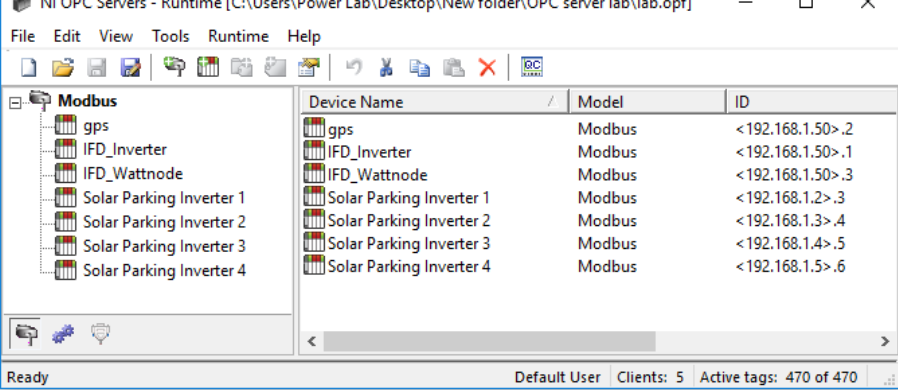
Figure 13. NI OPC server configuration.